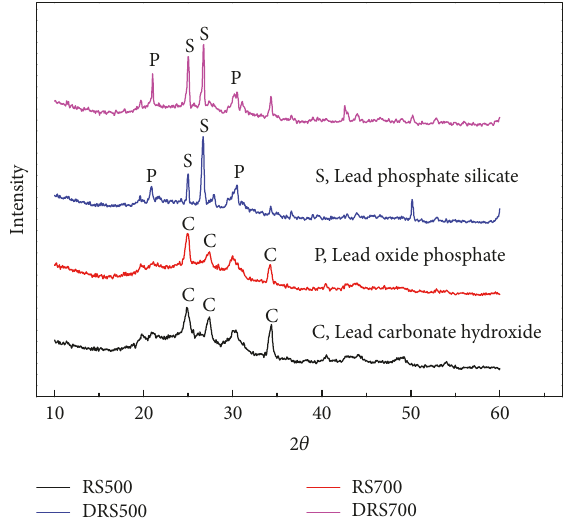
Figure 5: XRD diffraction patterns for RSBC-Pb and DRSBC-Pb.